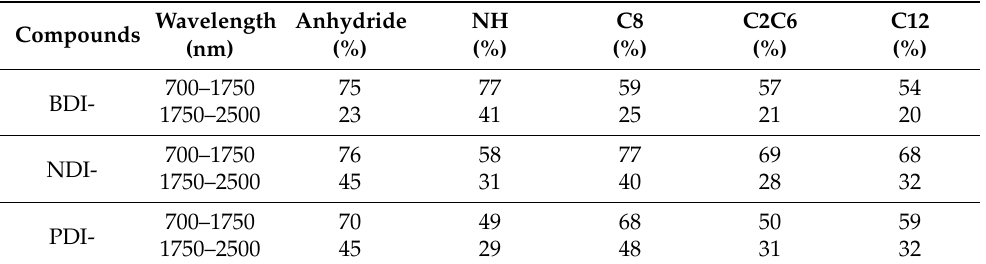
Figure 2. NIR reflectance spectra for three groups of: ( a ) BDI-, ( b ) NDI-, and ( c ) PDI-based compounds. Table 1. Average NIR reflectance of 700–1750 nm and 1750–2500 nm respectively for BDI-, NDI-, and PDI-based